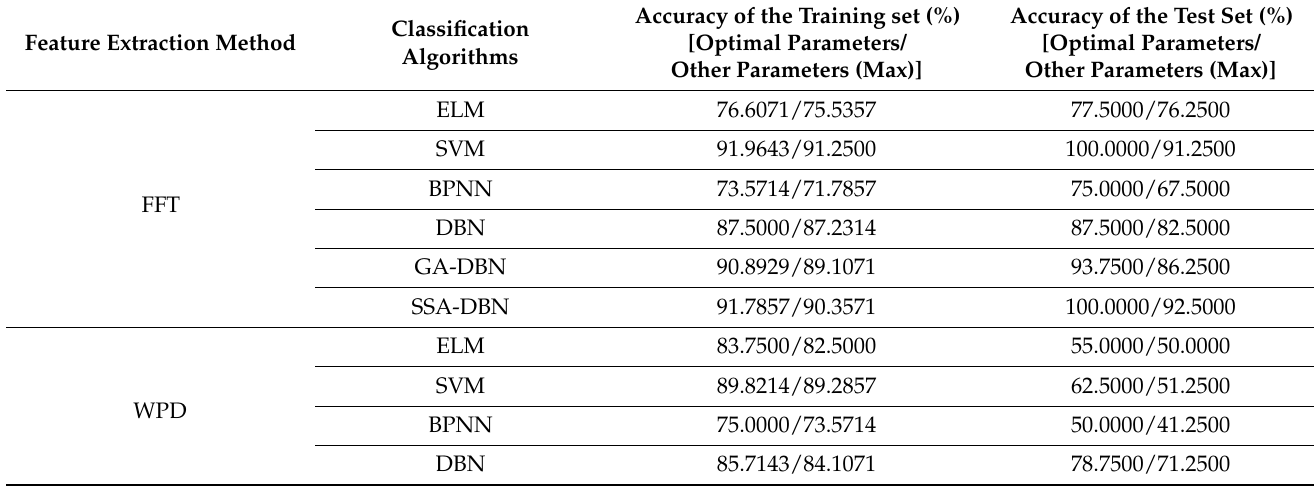
Table A2. The influence of parameter settings on the results of the no-load